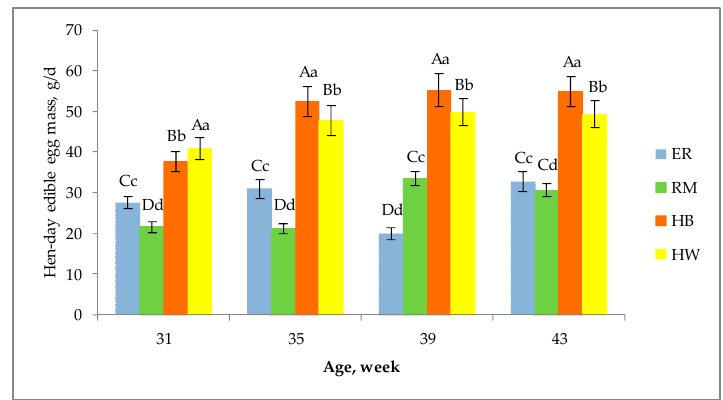
Figure 2. Effect of genotype 1 on the hen-day edible egg mass (lsmeans ± SD) according to the age of the hens. Different letters among columns at each age indicate different values. a, b, c, d: p < 0.05; A, B, C, D: p < 0.01. 1 Genotype: ER - Ermellinata di Rovigo; RM - Robusta maculata; HB - Hy Line Brown; HW - Hy Line White 36. Observations ( n ) per age (at 31, 35, 39, 43 weeks): ER (30, 30, 25, 27); RM (25, 22, 30, 29); HB (30, 30, 30, 30); HW (30, 30, 30, 28).